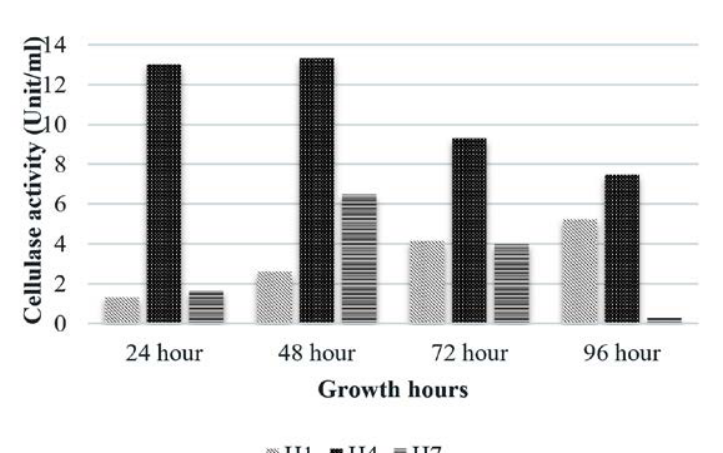
Fig. 5. Cellulase